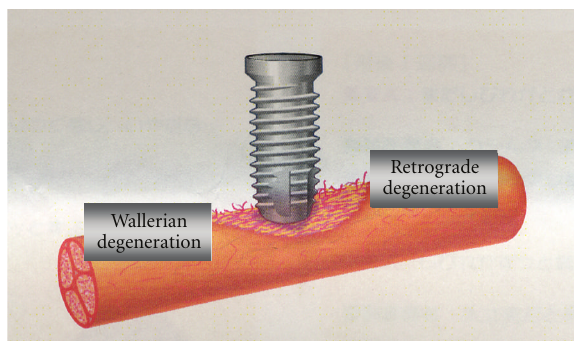
Figure 1: Degeneration following nerve injury by implant fixture [18].